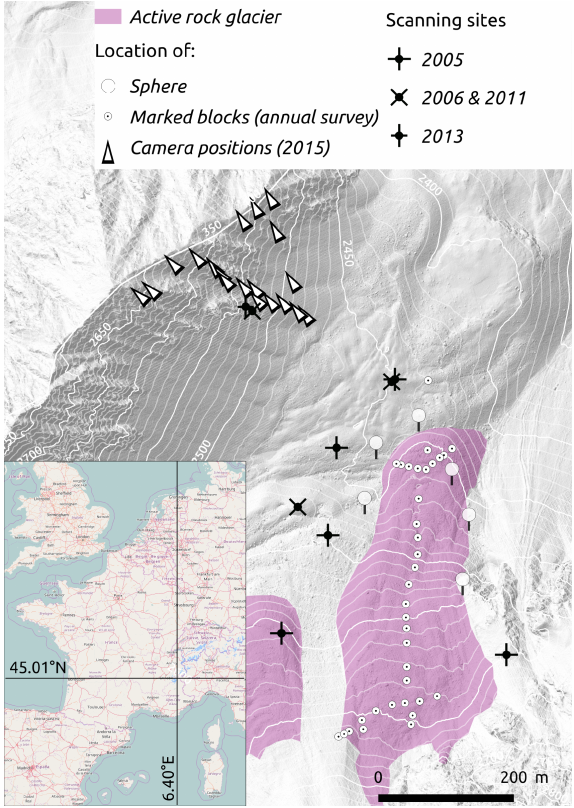
Figure 1. Map of the study area with the location of: (1) the targets (spheres with a diameter of 30 cm, anchored on stable terrain) used for georeferencing; (2) the annually surveyed marked blocks (DGPS); and (3) the cameras for the 2015 survey (symbols are oriented with the optical axis of the lens). The lower-left inset shows the general location of the study area in the French Alps (source: Open Street